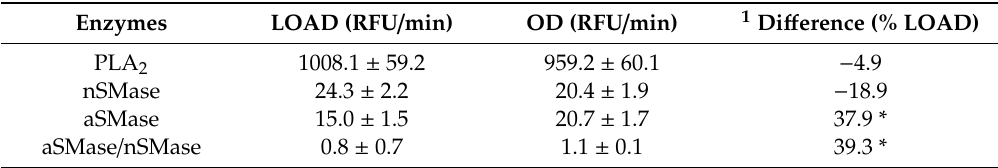
Table 5. Phospholipase A2 (PLA 2 ), neutral sphingomyelinase (nSMase), and acid sphingomyelinase (aSMase) activities in the cerebrospinal fluid (CSF) of late-onset Alzheimer’s disease (LOAD) and other dementia (OD)